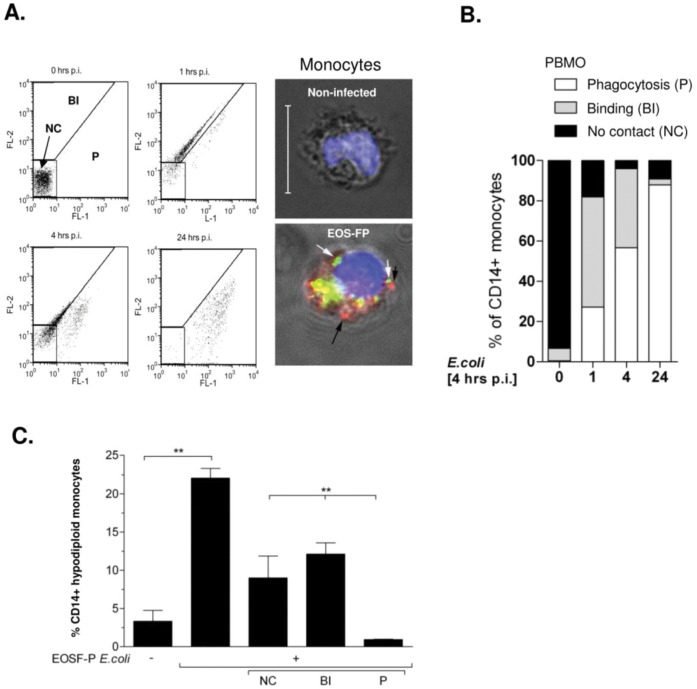
Transport to the phagolysosome is not obligatory for monocyte apoptosis.The gating strategy and nomenclature is shown by dot-plot analysis of monocytes, infected with EOS-FP E.coli for the indicated time intervals (A). Bound bacteria exhibit a red fluorescence, in the FL-2 channel (red bacteria in the micrograph, gated BI). Bacteria, transported to the phagolysosome, exhibit a green fluorescence in the FL-1 channel (green bacteria in the micrograph, gate P). Monocytes without bacterial contact were gated in NC. The chart (B) summarizes the proceeding the phagocytic process within the indicated time intervals. Details are given in the supplement. (C): Assessment of monocyte apoptosis by hypodiploid DNA content in total (second column) and in the three subfractions described (n = 7; ** = p<0.001).